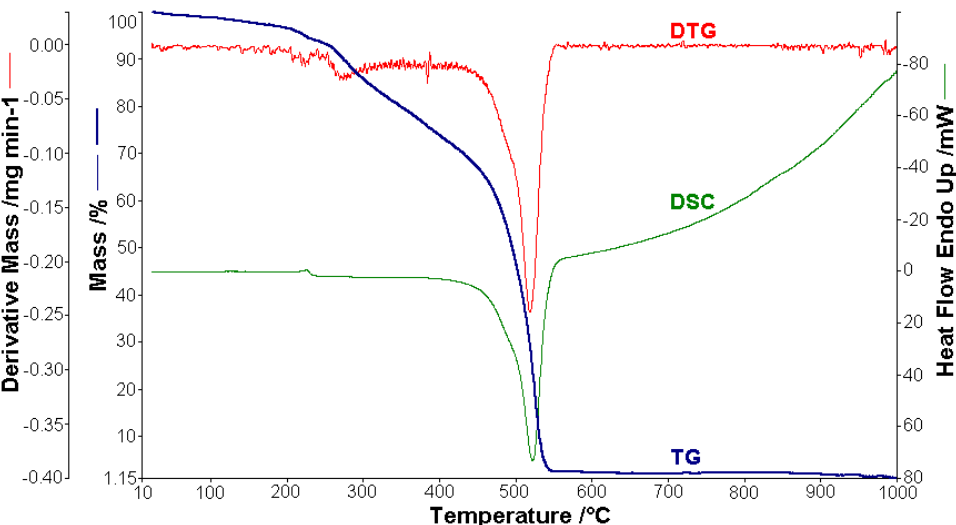
Figure 2. Thermoanalytical curves of [CoL 2 ] ∙ 1.5H 2 O.